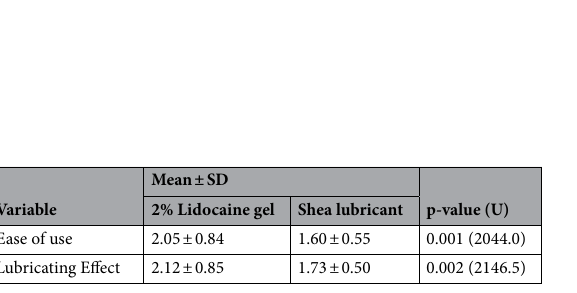
Table 3. Lubricating effect and Ease of use: mean